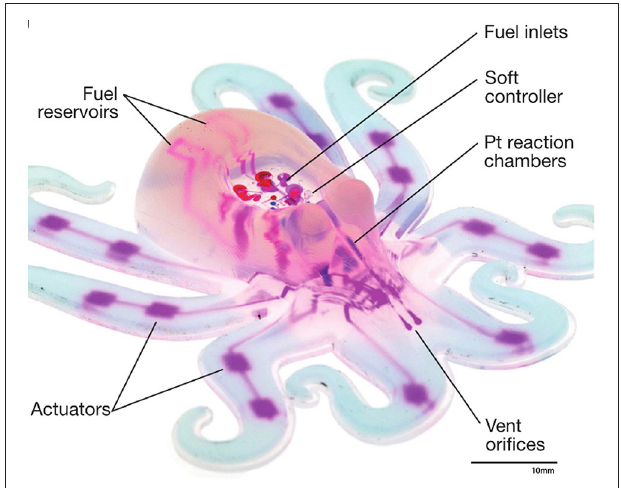
FIGURE 2 | The design of the so-called octobot is taken from the octopus. It is a fully soft, autonomous robot that is controlled via the embedded microfluidic soft controller and powered by monopropellant decomposition. Scale bar, 10mm, Source: Wehner et al. (2016). The figure is reproduced with the permission of the copyright holder [Springer Nature].